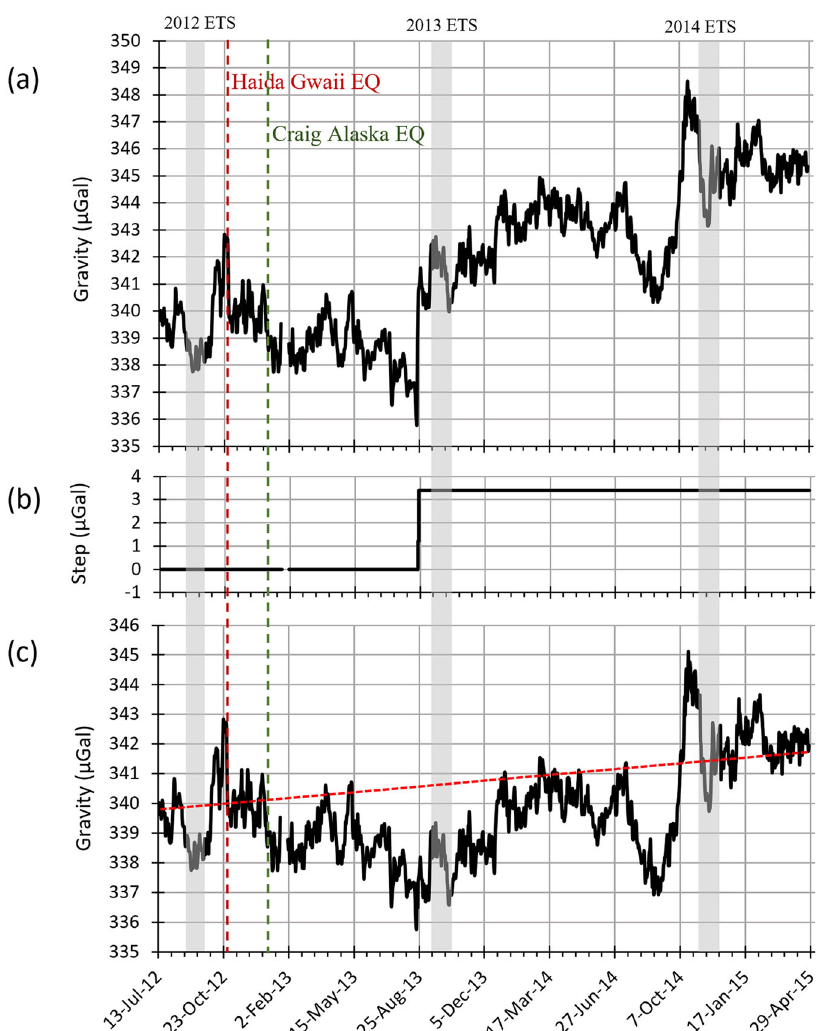
Fig. 2 Residual gravity signal after reduction of environmental effects. a Residual gravity of the SG after correction of tides, polar motion, atmospheric pressure, and soil moisture effects, before step correction; ( b ) Step function; ( c ) Residual gravity after correction of August 21st and 22nd, 2013 steps. The gray time-period columns represent ETS events at